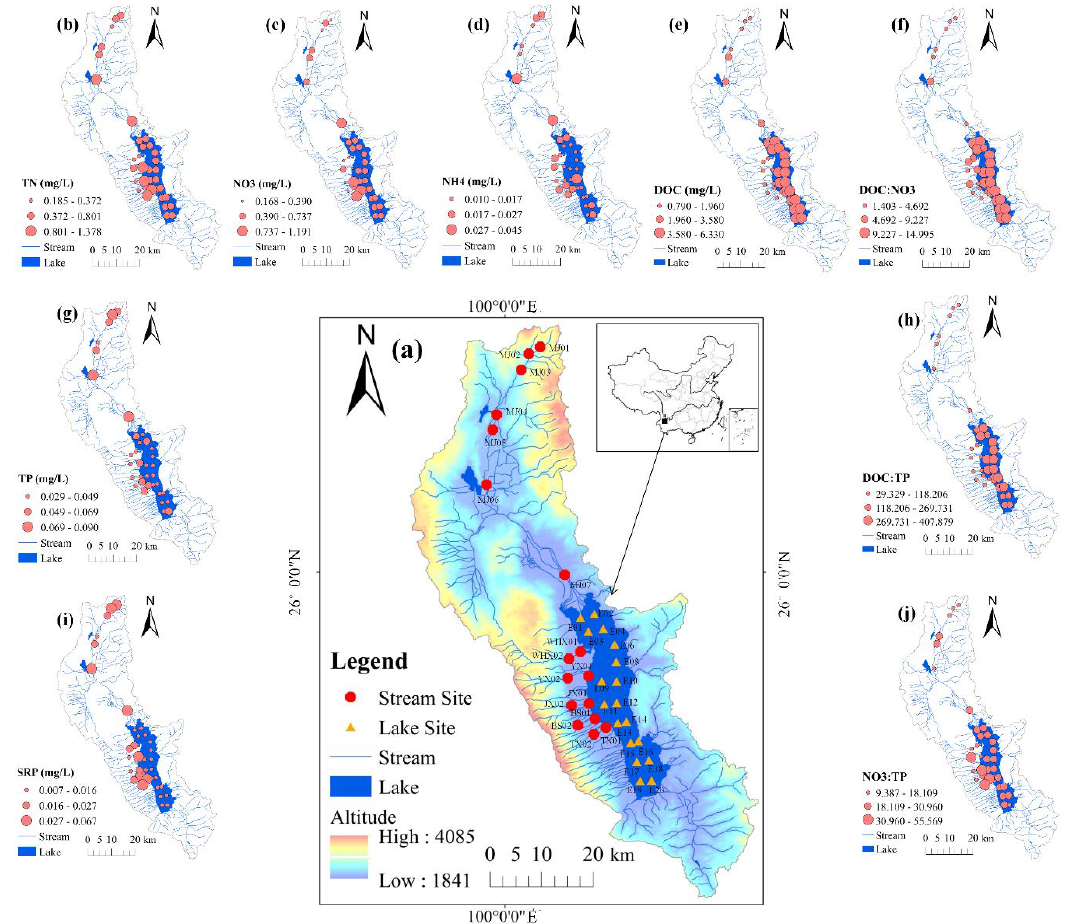
Figure 1. Study area and nutrient variables. ( a ) The distribution of sampling sites and ( b – j ) spatial patterns of nutrient variables in Erhai Lake and its tributaries. The map was created in ArcGIS 10.2 (http: // desktop.arcgis.com / en / arcmap / ) using ASTER GDEM data downloaded from the United States Geological Survey [ASTER GDEM is a product of the Ministry of Economy, Trade and Industry (METI) and the National Aeronautics and Space Administration (NASA)]. Table 1. Environmental variables in Erhai Lake and streams.